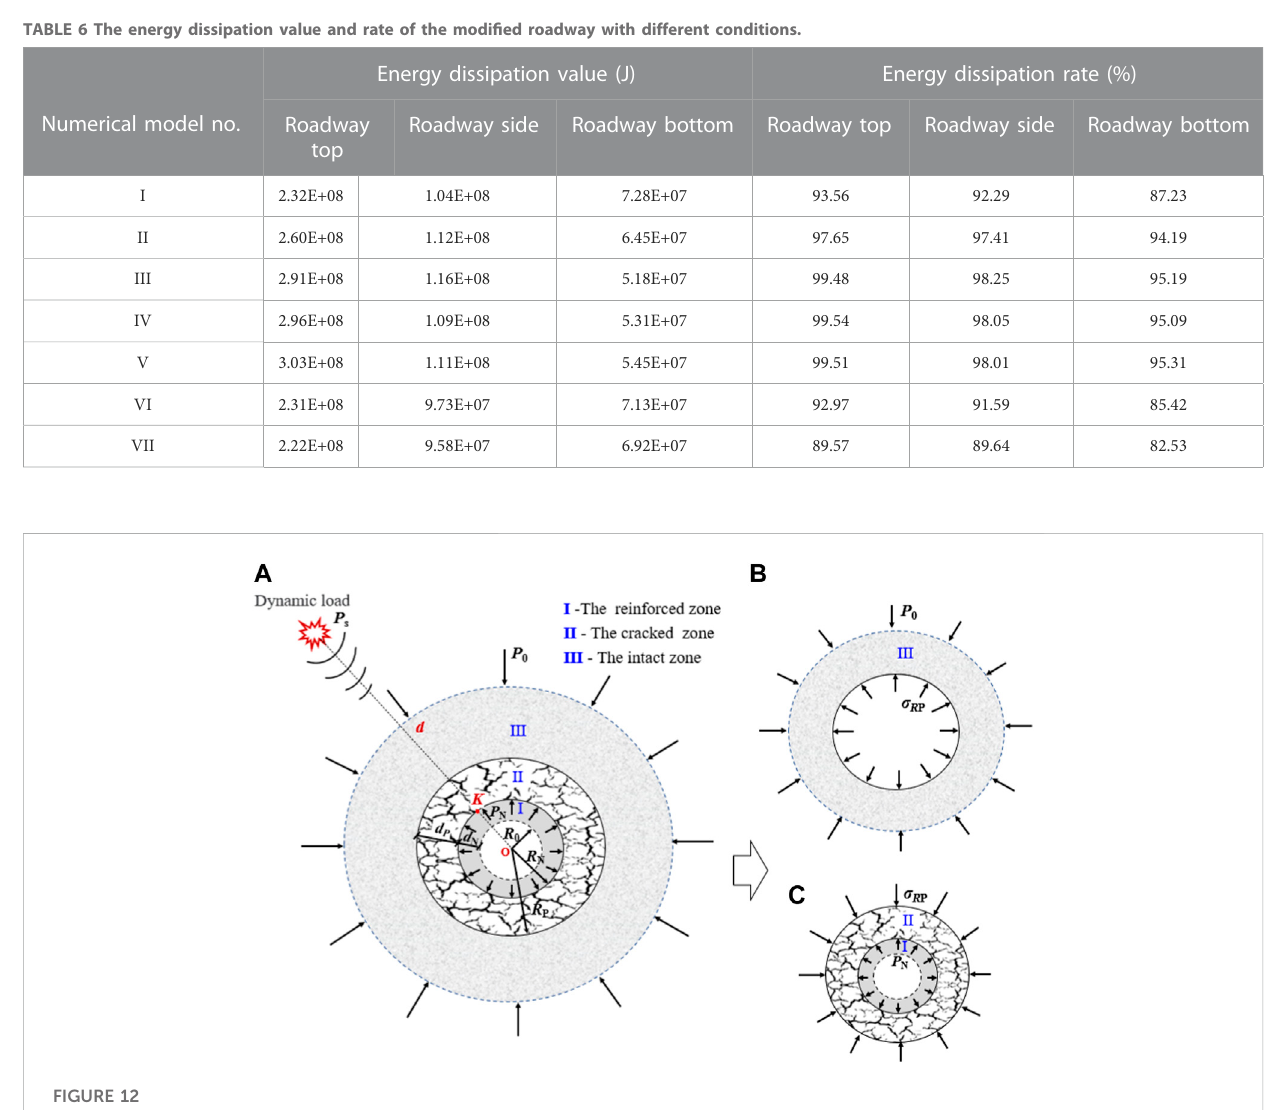
FIGURE 12 The mechanics model for (A) overall, (B) intact zone, and (C) cracked zone in a modi fi ed